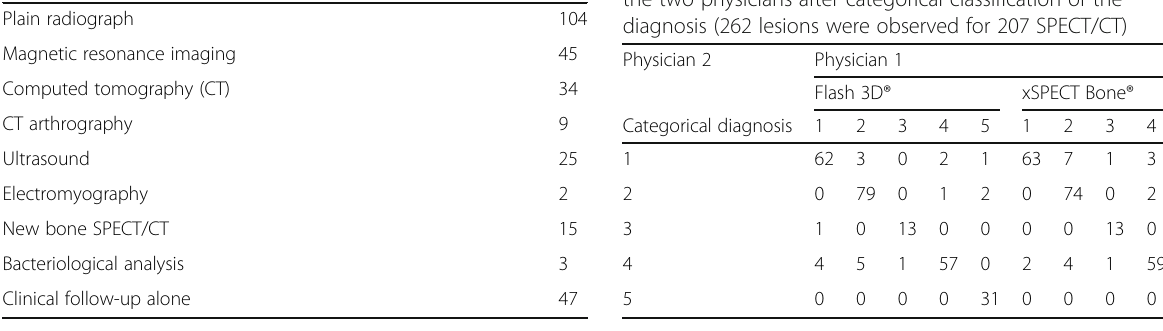
Table 5 The contingency table of the diagnosis according to the two physicians after categorical classification of